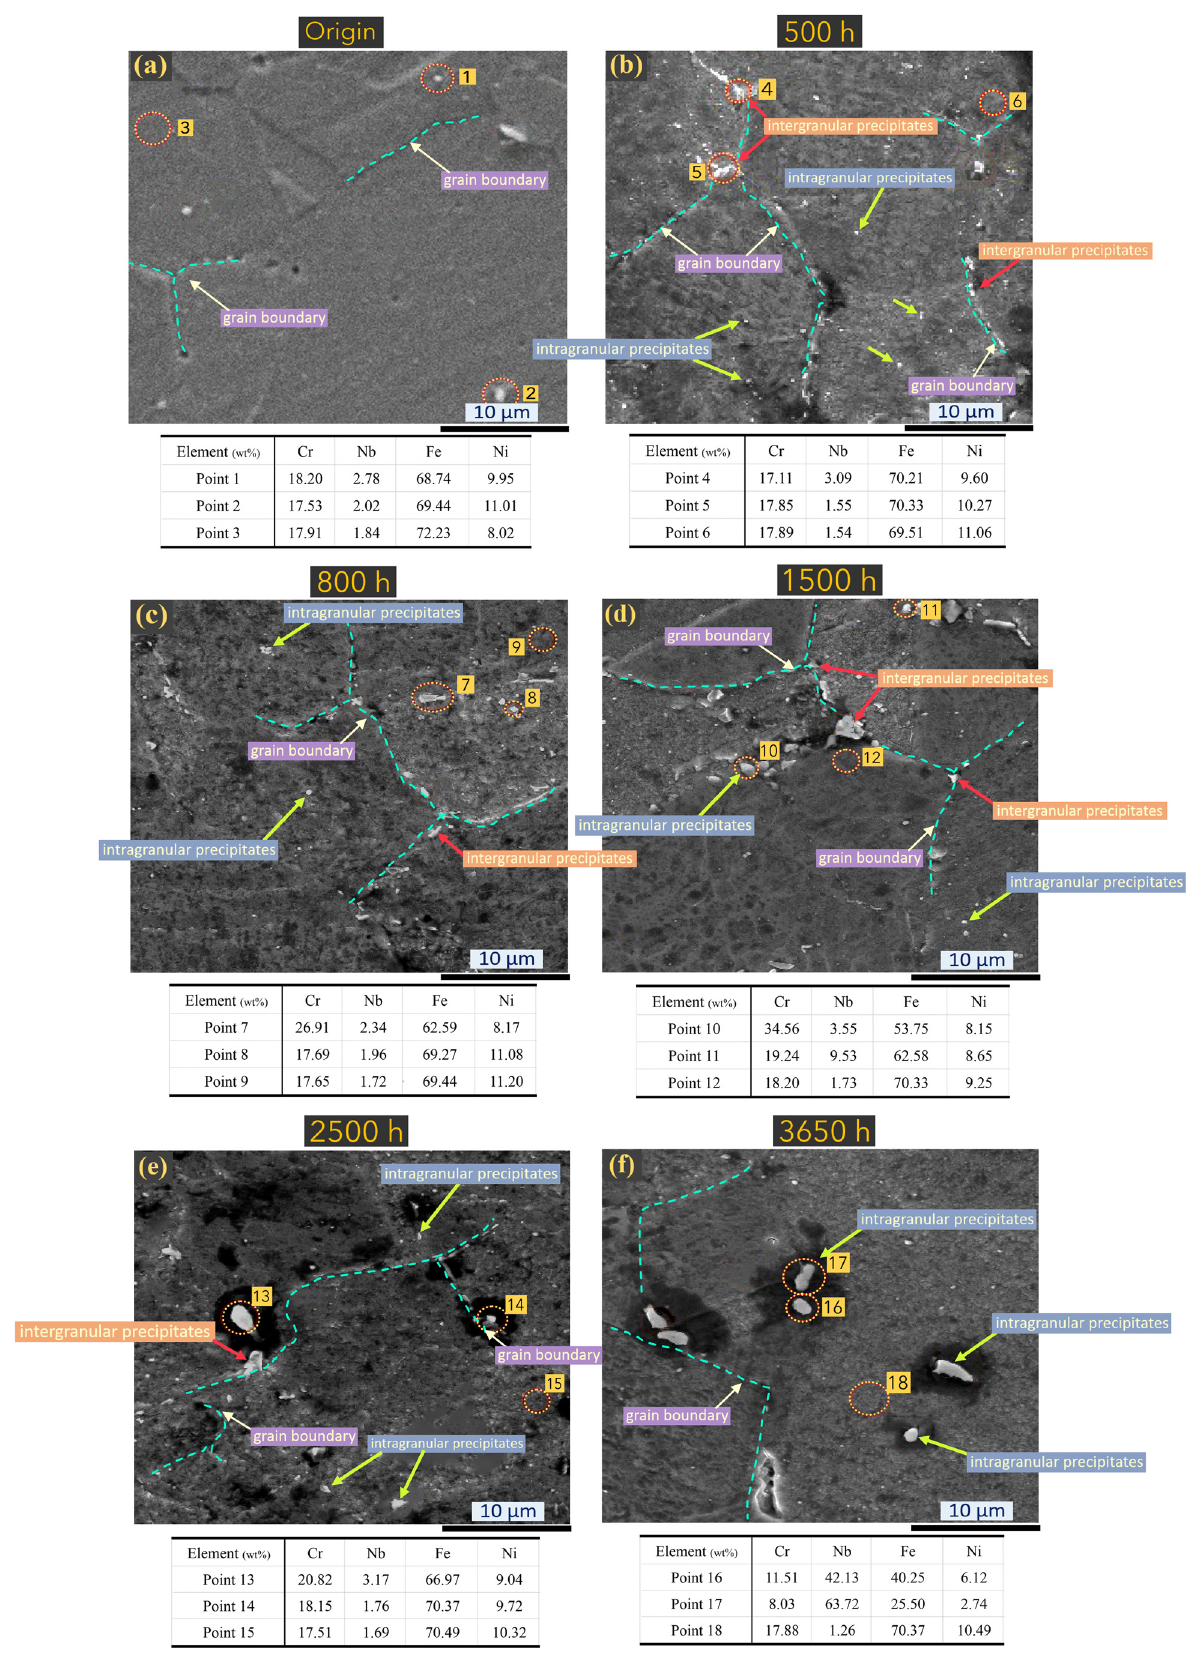
Figure 3: The SEM observations and EDS analysis of TP347HFG steel during the thermal aging: ( a ) origin, ( b ) 500 h, ( c ) 800 h, ( d ) 1,500 h, ( e ) 2,500 h, and ( f ) 3,650